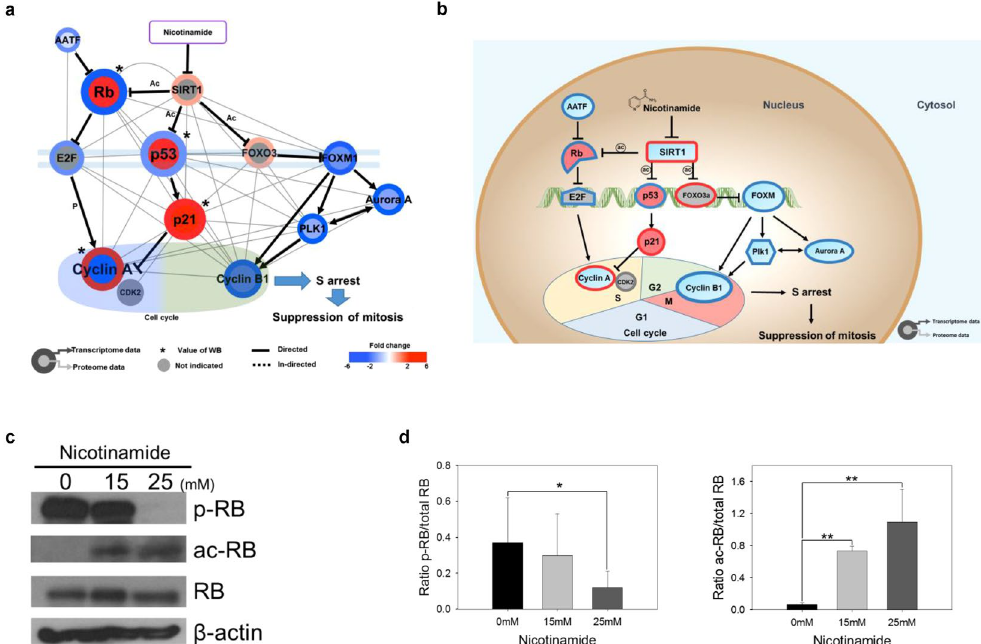
Figure 4. Nicotinamide induces cell cycle arrest. ( a ) Cytoscape visualization of cell cycle regulatory network. The colors of the border and inside circle indicate the expression levels of transcriptome and proteome data, respectively. Gray edge indicates the protein-protein interaction based on the STRING database, whereas the arrows and inhibition symbols represent the activation and repression information, respectively. Nodes with asterisks indicate that the protein expression was assessed by only western blotting without the use of proteome data. There is no significant difference regarding the expression level if the color of the node is gray. ( b ) Proposed model of nicotinamide-induced cell cycle interaction network. Networks are represented by proteome, transcriptome and western blotting data. Red indicates increased expression, blue indicates decreased expression and gray indicates no significant difference. ( c ) Expression of RB and the phosphorylation and acetylation of RB in nicotinamide-treated cells were examined via western blotting. ( d ) Densitometry analysis of p-RB and ac-RB was quantitated using ImageJ. Values were normalized to the levels of RB. The data represent the mean ± SD ( * P < 0.05, ** P < 0.01). Abbreviations: ac - acetylation, p - phosphorylation, WB - western